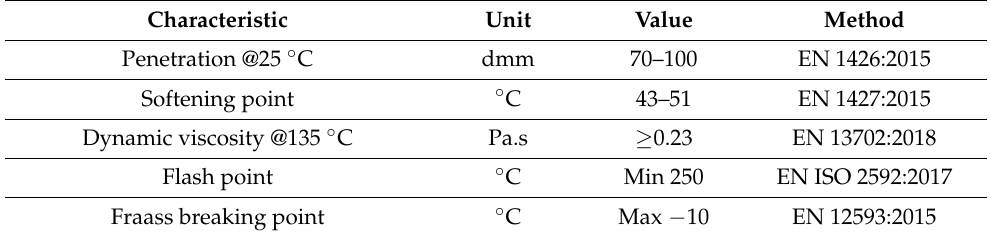
Table 1. Some of the given characteristics of the base virgin 70/100 bitumen.